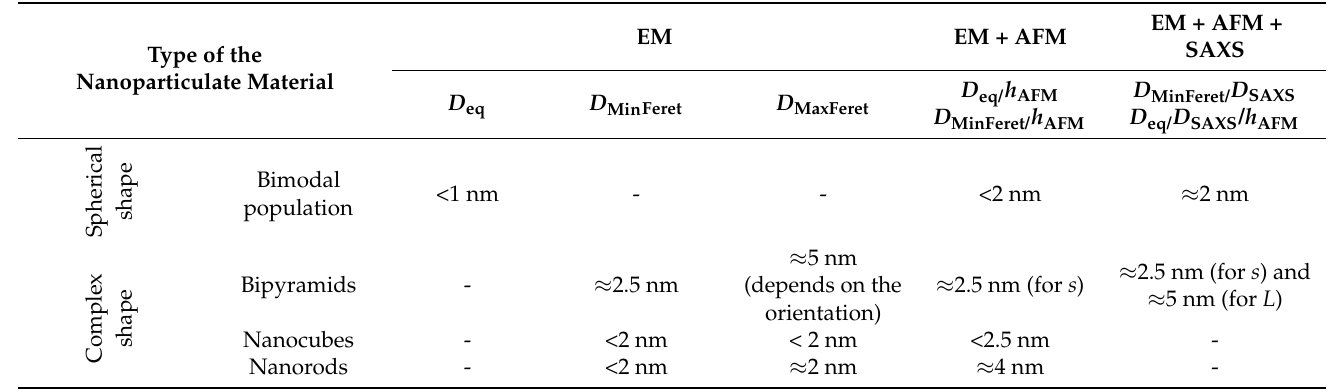
Table 9. Dispersion of the data measured by the different techniques used in the nPSize project as a function of the particle